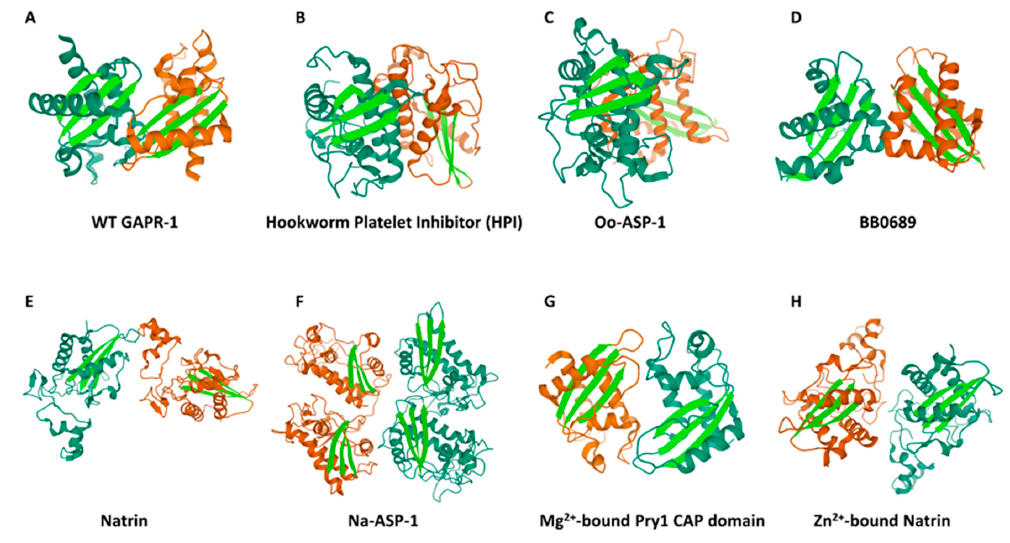
Figure 3. Tertiary structures of dimeric cysteine-rich secretory proteins, antigen 5 and pathogenesis- related proteins group 1 (CAP) superfamily proteins. The dimeric tertiary structures of GAPR-1 ( A ), Hookworn Paltelet Inhibitor (HPI) ( B ), Oo-ASP-1 ( C ), BB0689 ( D ), Natrin ( E ), Na-ASP-1 ( F ), Mg 2+ -bound Pry1 CAP domain ( G ) and Zn 2+ -bound Natrin ( H ) are presented with one monomer in dark green and another monomer in orange. β -Sheets are highlighted in light green. Images were created using 3D view in PDB website (www.rcsb.org) and the following PDB entry files: 1SMB (GAPR-1); 4TPV (Hookworn Paltelet Inhibitor, HPI); 4G2U (Oo-ASP-1); AD53 (BB0689); 2GIZ (Natrin); 3NT8